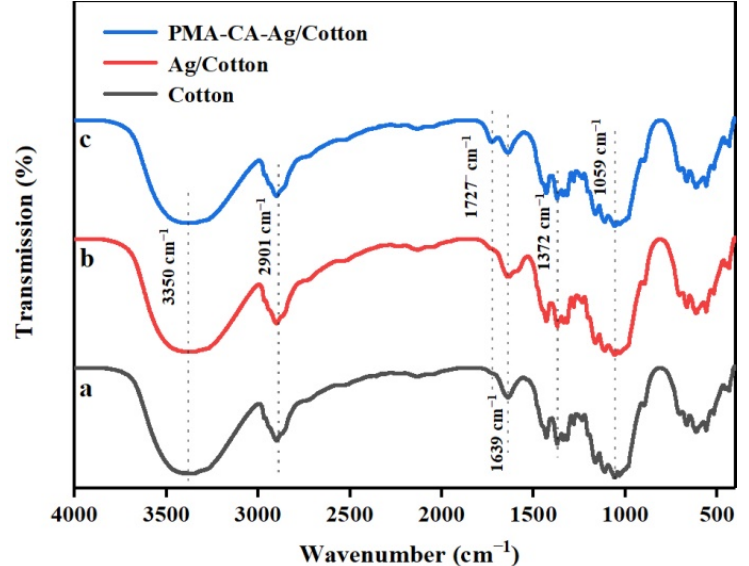
Figure 7. FT-IR image of Unfinished Cotton ( a ), Ag/Cotton ( b ) and PMA-CA-Ag/Cotton ( c